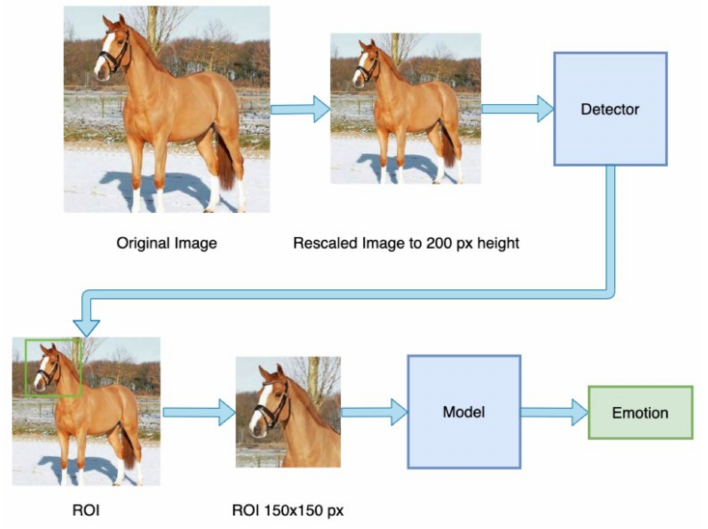
Figure 3. System process